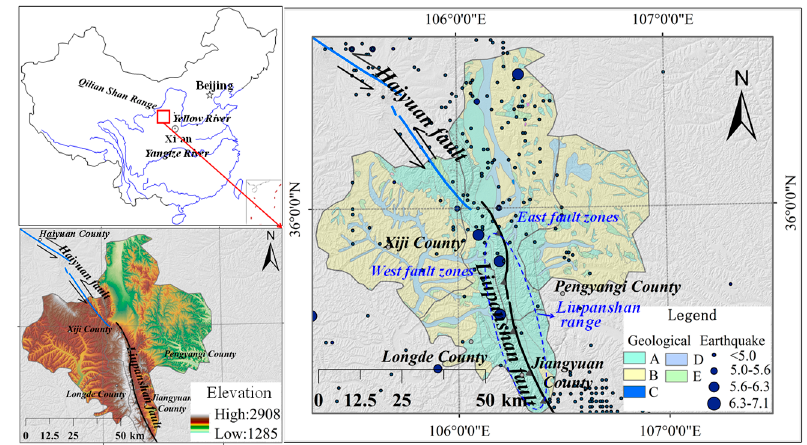
Figure 1. The engineering geology and faults around the study region: ( A ) Hard rock; ( B ) loess; ( C ) moderate rock; ( D ) very soft rock; and ( E ) soft rock. (The earthquake data is from the China Earthquake Administration).